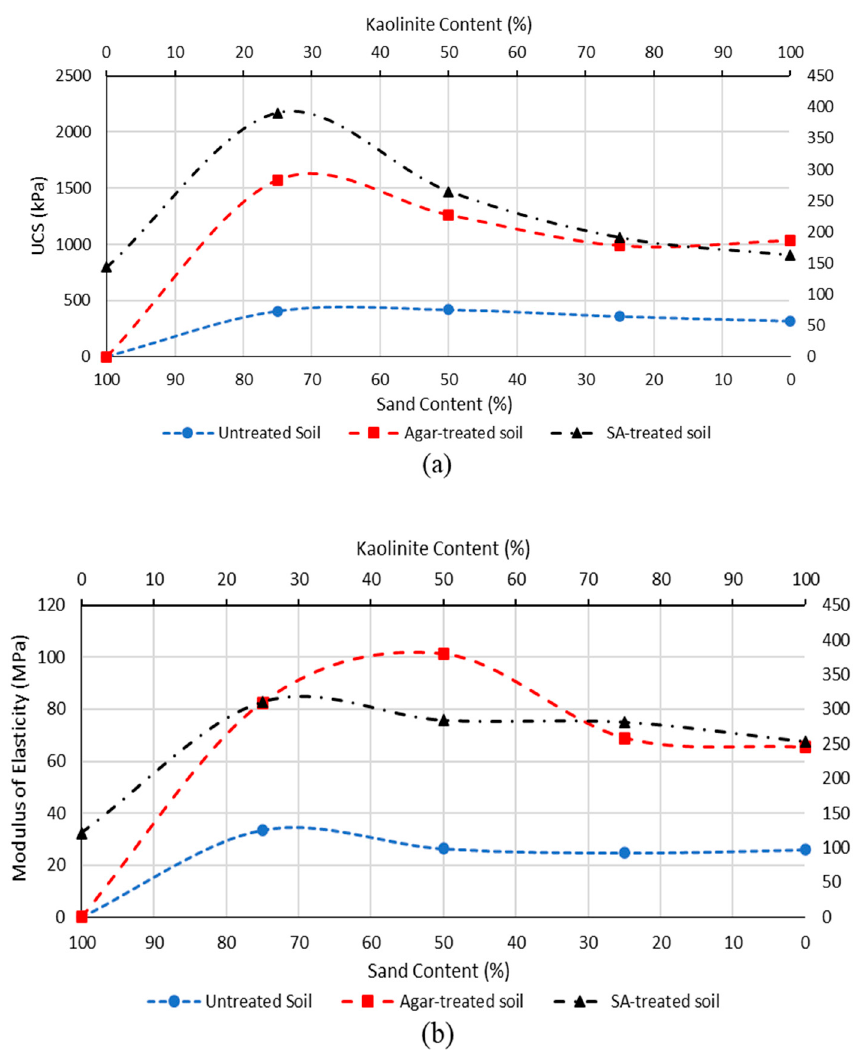
Figure 5. Soil type effect on characteristics of treated soil ( a ) UCS, ( b ) modulus of elasticity.